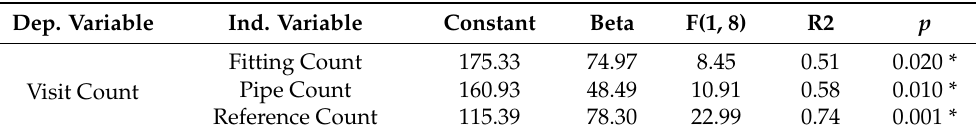
Table 7. Linear regression—pipefitter interaction (visit count) by visual drawing complexity (number of fittings, pipes, and references) (N =